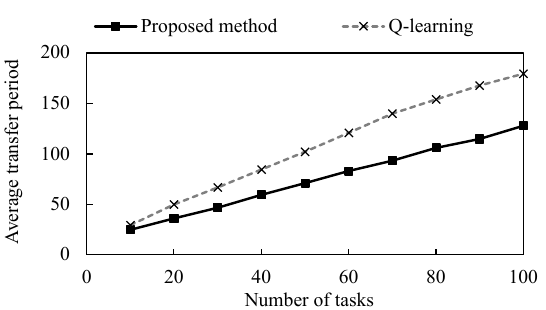
Figure 13. Comparison of total traveling time on dynamic